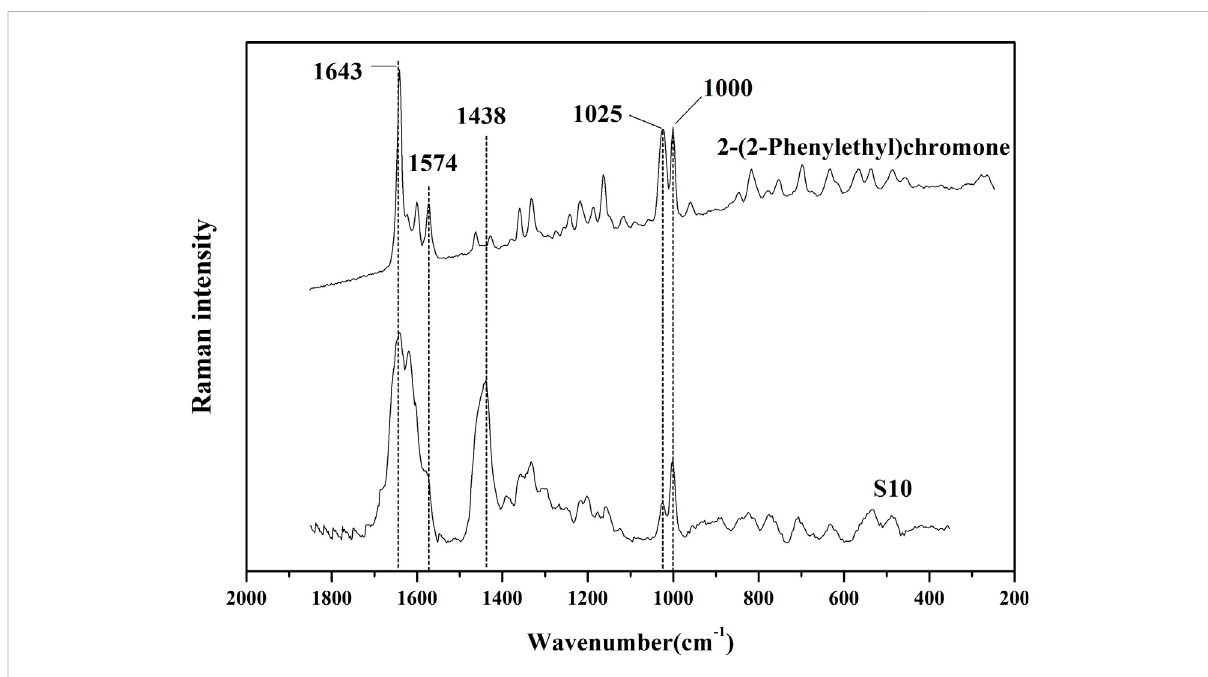
FIGURE 6 Comparison of Raman spectrums of S10 (representative sample of SFE) and 2-(2-Phenylethyl) chromone (standard reference